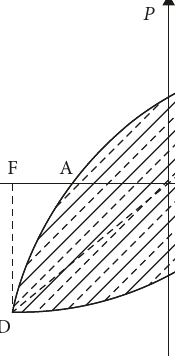
Figure 13: Calculation of dissipative